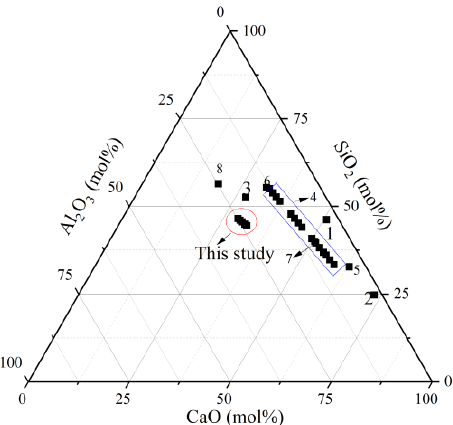
Figure 14. Ternary phase diagram of the binders (1 [15] 2 [32] 3 [33] 4 [17] 5 [34] 6 [35] 7 [36] 8